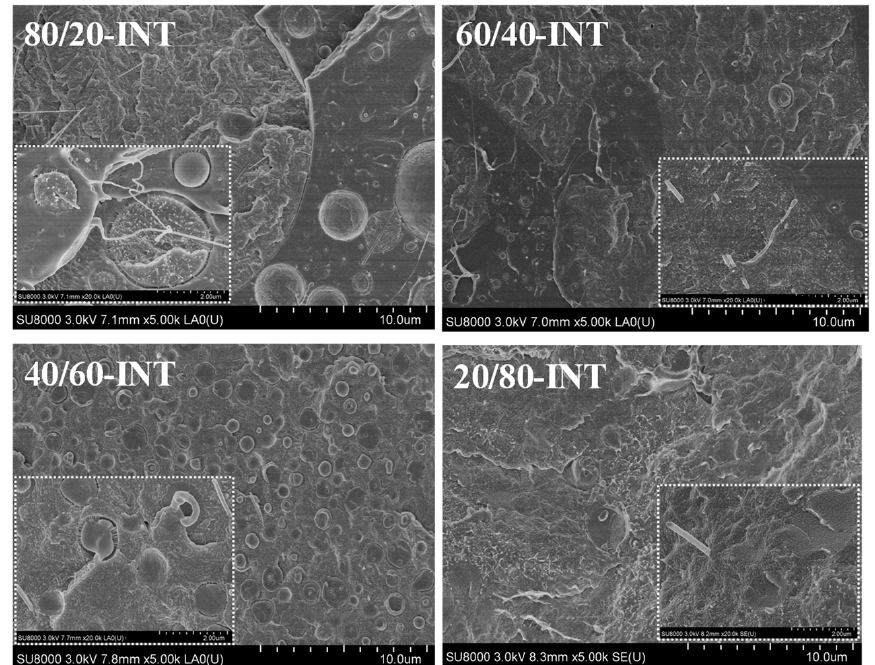
Figure 1. High-resolution SEM micrographs of the PLLA/nylon 11 blends.